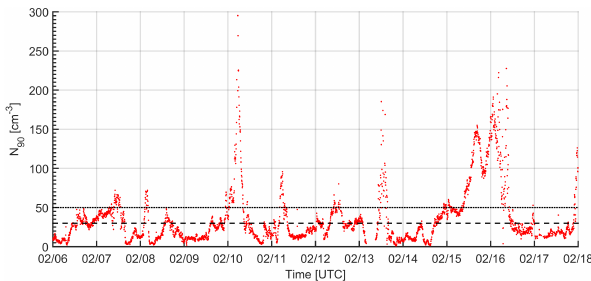
Figure 3. Time series of N 90 concentration for the analysis pe- riod. Dashed line denotes the 30cm − 3 background concentration described in Herrmann et al. (2015); the dotted line denotes this 50cm − 3 threshold used to distinguish free tropospheric conditions.